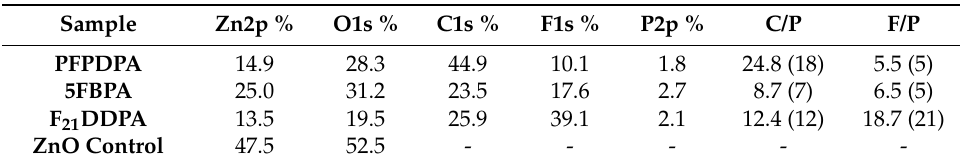
Table 1. Atomic percentages and C/P and F/P ratios determined by XPS and compared with theoretical values calculated from the chemical formula (numbers in parenthesis).